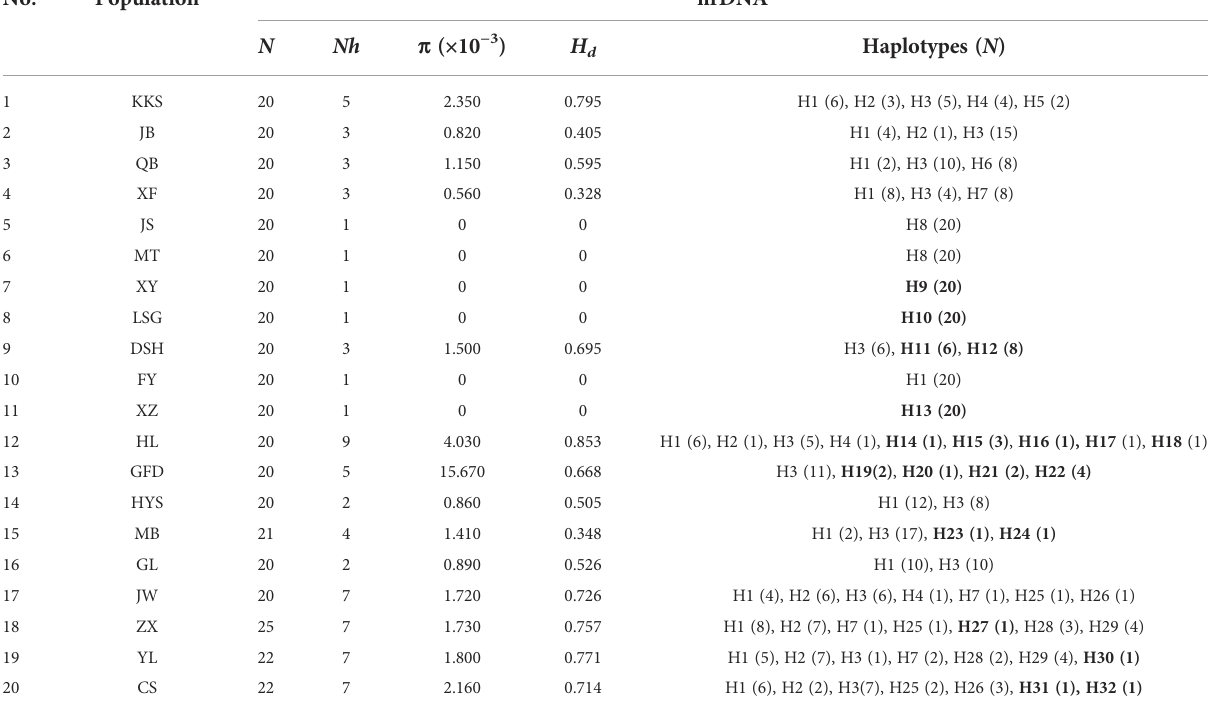
TABLE 3 Distribution and genetic diversity parameters of nrDNA haplotypes in Ch.